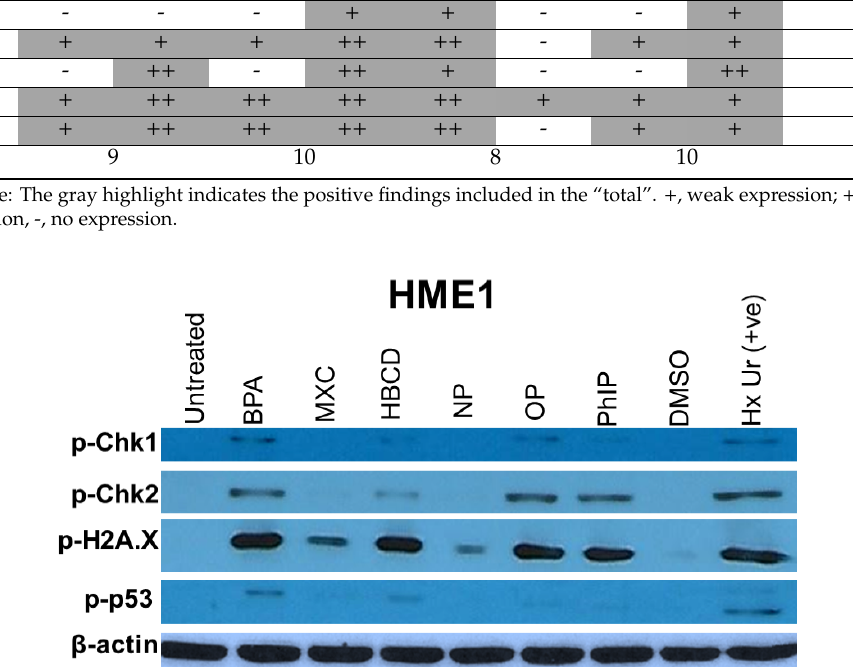
Figure 2. DNA damage response detected in the mammary epithelial cells HME1. Cells were treated with toxic agents (bisphenol A (BPA), methoxychlor (MXC), hexabromocyclododecane (HBCD), 4-nonylphenol (NP), 4-tert-octylphenol (OP), and 2-amino-1-methyl-6-phenylimidazo [4–b] pyridine (PhIP) at 0.0043, 0.0028, 0.0015, 0.0045, 0.0048, 0.0044 nM, respectively) for two months, then the expression of DNA damage response markers were tested by Western blot using antibodies against phospho-Chk1 (Ser345), phospho-Chk2 (Thr68), phospho-p53 (Thr18), and phosph-Histone H2A.X (Ser139). Markers were expressed to